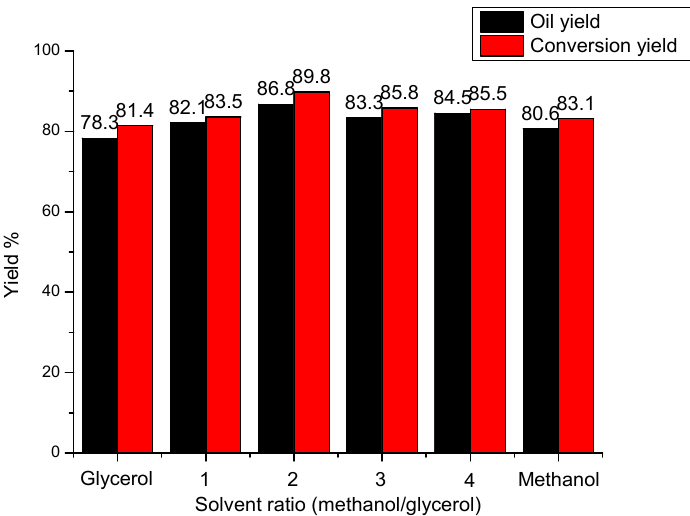
Figure 3. Effect of solvent ratio on lignin conversion. Reaction conditions: reaction temperature was 160 °C, reaction time was 1 h, catalyst dosage was 5.0 wt %.